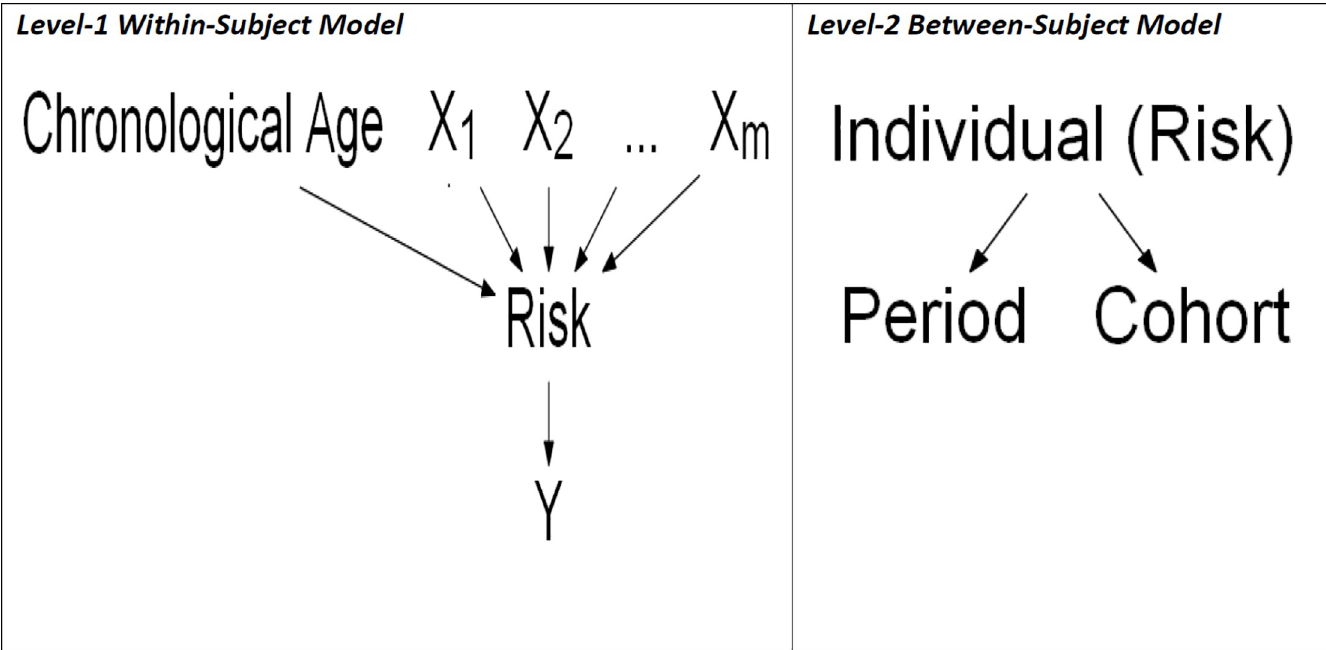
Fig 1. A conceptual diagram for the risk-period-cohort (RPC) model using the hierarchical APC (HAPC) framework. Structural diagram of the HAPC model using RPC analyses (not including a quadratic risk effect on the outcome). This diagram is adapted similarly from work by Bell and Jones (2014)[9]. Each period and cohort will include the spectrum of individuals of different risk levels. However, this is cross-classified since each period does not include all cohort groups and vice versa.